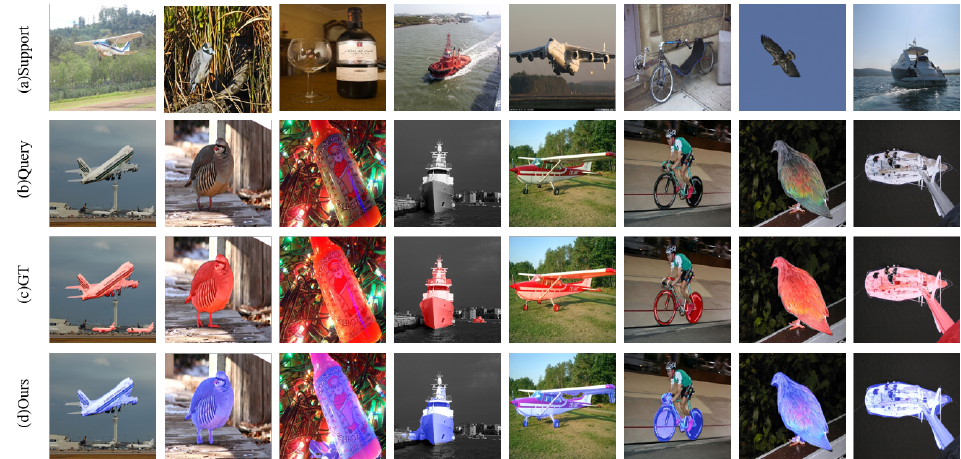
Figure 10. Qualitative results of the proposed PFMNet. The samples are from PASCAL-5 i . From top to bottom: ( a ) support images, ( b ) query images, ( c ) ground truth of query images, and ( d ) predictions of PFMNet.